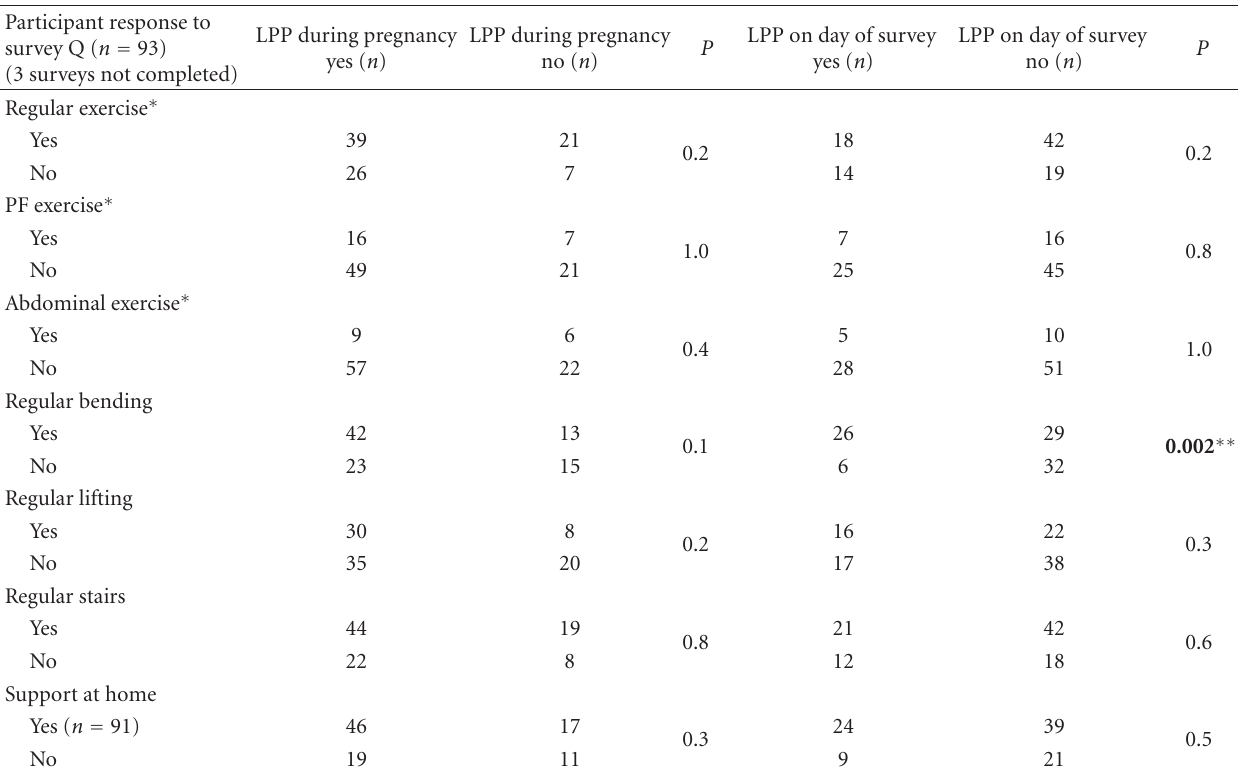
Table 3: LPP, exercise habits, and